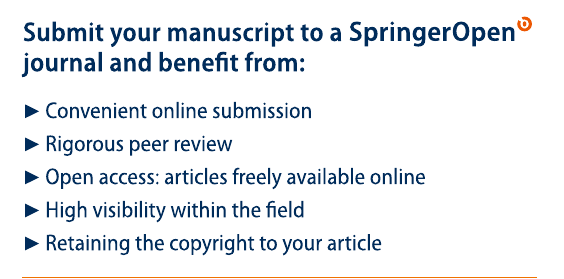
Murad SMW (2016) Is the exchange rate of Bangladesh mean reverting? A panel unit root approach. Asian Econ Financ Rev 6(2):100 – 108. Newey WK, West KD (1987) A simple, positive semi-definite, Heteroskedasticity and autocorrelation consistent covariance matrix. Econometrica 55(3):703 – 708. Newey WK, West KD (1994) Automatic lag selection in covariance matrix estimation. Rev Econ Stud 61:631 – 653. O ’ Connell PG (1998) The overvaluation of purchasing power parity. J Int Econ 44:1 – 9. Ogawa E, Kawasaki K (2006) Adopting a common currency basket arrangement into the ASEAN plus three. In: RIETI Discussion Paper Series 06-E-028, June. Pedroni P (2000) Fully modified OLS for heterogeneous cointegrated panels. In: Baltagi BH (ed) Nonstationary panels, panel cointegration, and dynamic panels, advances in econometrics, vol 15, pp 93 – 130. Pedroni P (2001) Purchasing power parity tests in cointegrated panels. Rev Econ Stat 83:727 – 731. Persyn D, Westerlund J (2008) Error-correction – based cointegration tests for panel data. Stata J 8:232 – 241. Pesaran MH (2007) A simple panel unit root test in the presence of cross section dependence. J Appl Econ 22(2):265 – 312. Rogoff K (1996) The purchasing power parity puzzle. J Econ Lit 34:647 – 668. Sarno L, Taylor, M (2002) IMF Econ Rev 49: 65. https://doi.org/10.2307/3872492. Soon SV, Baharumshah AZ, Shariff NSM, Ibrahim S (2017) Currency crises and purchasing power parity in the Asian countries: evidence based on second-generation panel unit-root tests. Malays J Econ Stud 54(1):41 – 59. Taylor A, Taylor M (2004) The purchasing power parity debate. J Econ Perspect 18:135 – 158. Taylor MP (2006) Real exchange rates and purchasing power parity: mean-reversion in. Economics 16:1 – 17. Taylor MP, Sarno L (1998) The behavior of real exchange rates during the post- Bretton woods period. J Int Econ 46(2):281 – 312. Westerlund J (2007) Testing for error correction in panel data. Oxf Bull Econ Stat 69:709 – 748. Wu JL, Chen SL (1999) Are real exchange rates stationary based on panel unit- root tests? Evidence from Pacific Basin countries. Int J Financ Econ 4:243 – 252. Wu JL, Tsai LJ, Chen SL (2004) Are real exchange rates non-stationary? The Pacific Basin perspective. J Asian Econ 15(2):425 – 438. Wu JL, Wu S (2001) Is purchasing power parity overvalued? J Money Credit Bank 33:804 – 812. Zurbruegg R, Allsopp L (2004) Purchasing power parity and the impact of the east Asian currency crisis. J Asian Econ 15:739 –